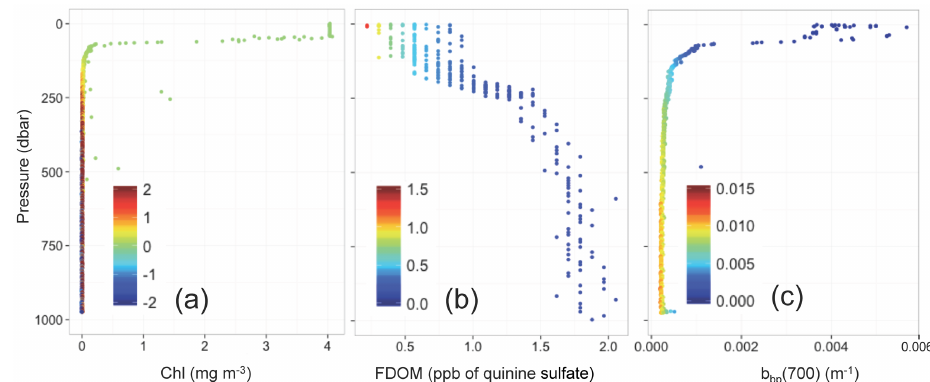
Figure 12. Ratios between sensor sensitivity thresholds and quality-controlled values of (a) chlorophyll a concentration (Chl), (b) fluo- rescent dissolved organic matter (FDOM), and (c) particulate backscattering coefficients at 700nm ( b bp (700)). Sensor sensitivity limits are 0.007mgm − 3 , 0.28ppb of quinine sulfate, and 2.2 × 10 − 6 m − 1 for Chl, FDOM, and b bp (700), respectively. Measurements used as examples correspond to quality-controlled profiles shown in Figs. 3a, 4b, and